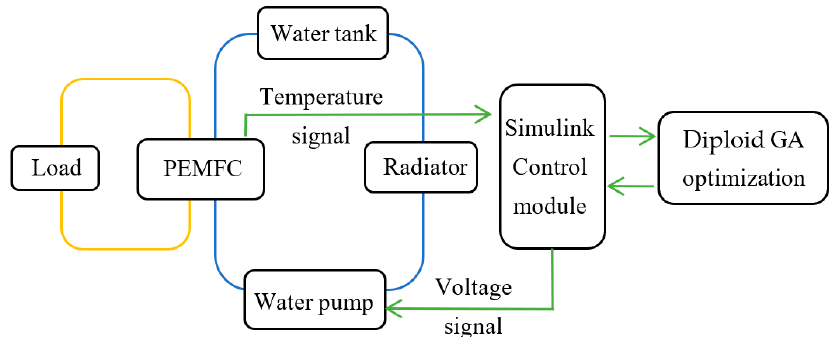
Figure 1. Fuel cell thermal management circuit diagram.